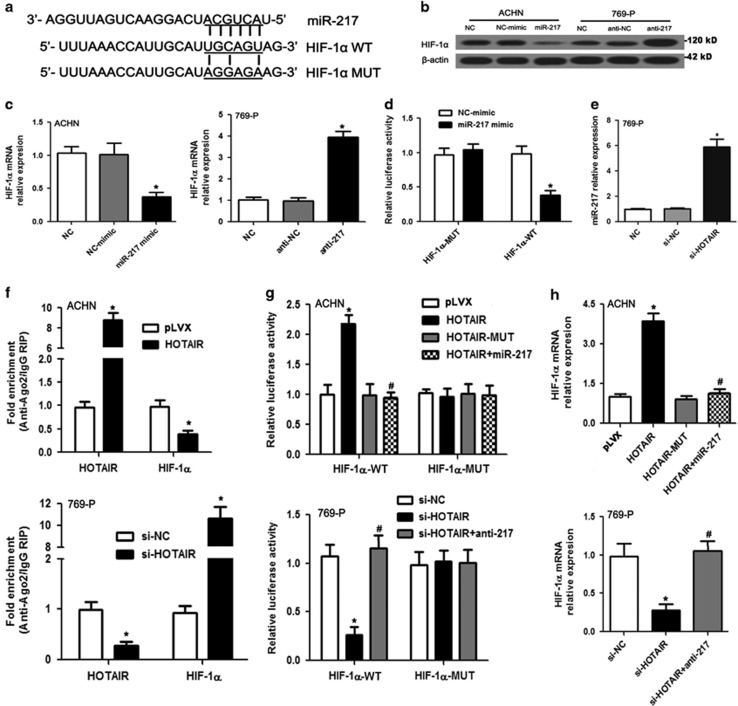
HOTAIR functions as a ceRNA for miR-217 to facilitate HIF-1α expression. (a) The putative miR-217 binding 3′UTR of HIF-1α (HIF-1α-WT) and HIF-1α mutation sequence (HIF-1α-MUT). The protein (b) and mRNA (c) levels of HIF-1α in ACHN and 769-P cells. *P<0.05 versus NC group. (d) Luciferase activity assay. *P<0.05 versus NC-mimic group. (e) The expression of miR-217 in 769-P cell transfected with si-NC or si-HOTAIR. *P<0.05 versus NC group. Data were analyzed by unpaired Student’s t-test. (f) RIP assay of the enrichment of Ago2 on HOTAIR and HIF-1α transcripts relative to IgG in cells transfected with pLVX-HOTAIR or si-HOTAIR. (g) Luciferase activity of pGL3 reporters which contained wild type or mutant HIF-1α 3′UTR with indicated treatment in Rcc cells. (h) qRT-PCR analysis for HIF-1α mRNA expression in ACHN and 769-P cells. *P<0.05 versus pLVX group, #P<0.05 versus HOTAIR group in ACHN cells; *P<0.05 versus si-NC group, #P<0.05 versus si-HOTAIR group in 769-P cells. Statistical analysis was conducted using One-way ANOVA